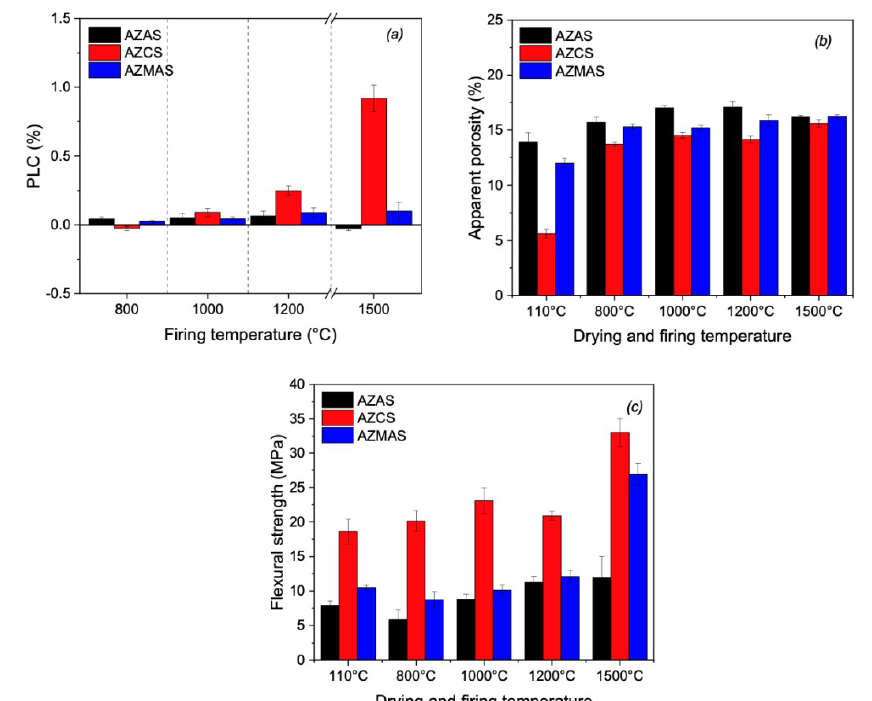
Figure 4. (a) Permanent linear change (PLC), (b) cold flexural strength and (c) apparent porosity of the dried and fired castable